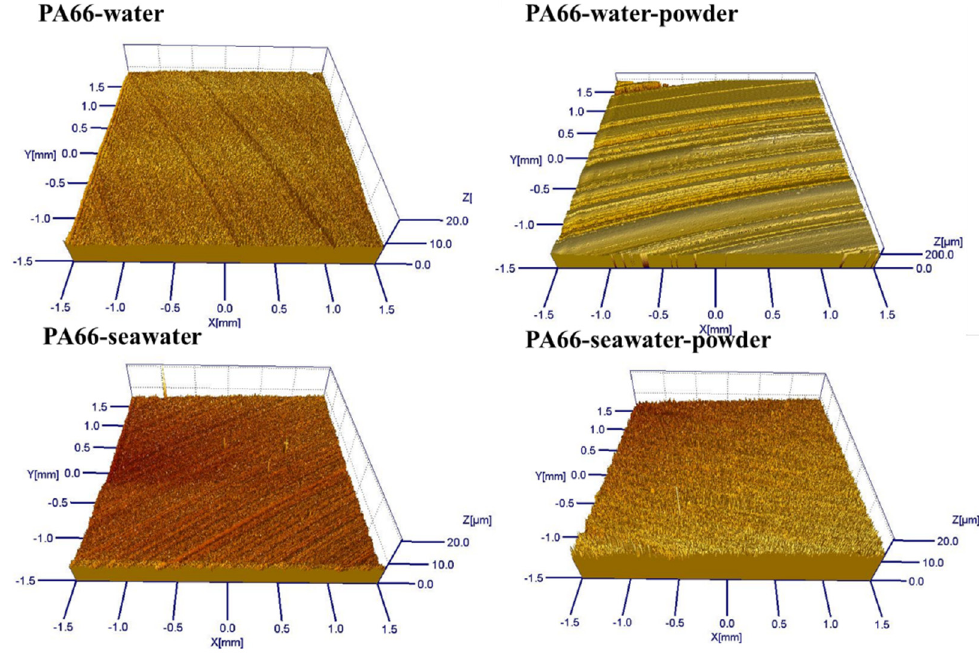
Figure 10. Micrograph images captured using white-light interference three-dimensional profilometer. Table 6. The roughness of PA66 pins surface.